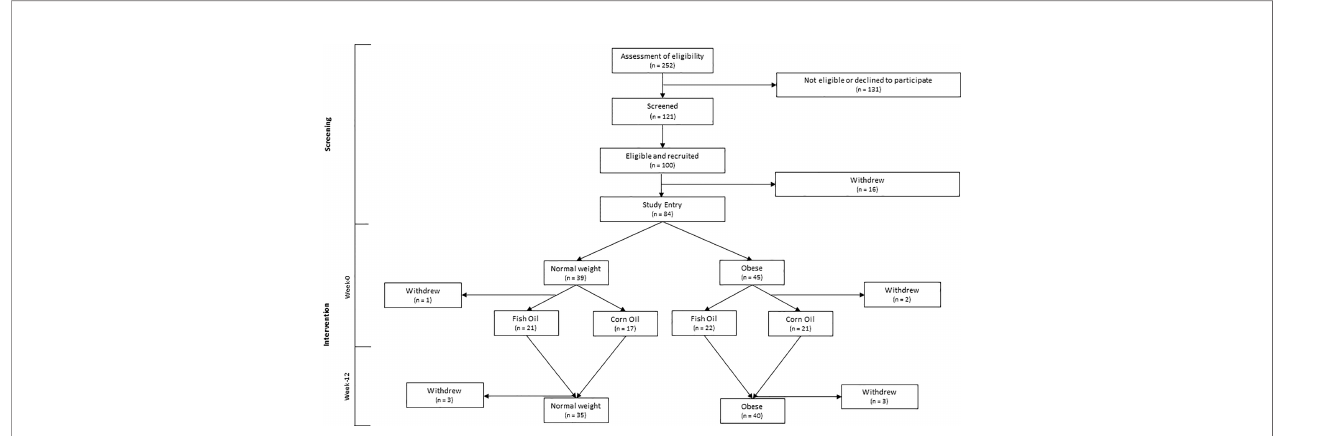
FIGURE 1 | CONSORT diagram of participant inclusion and fl ow through the